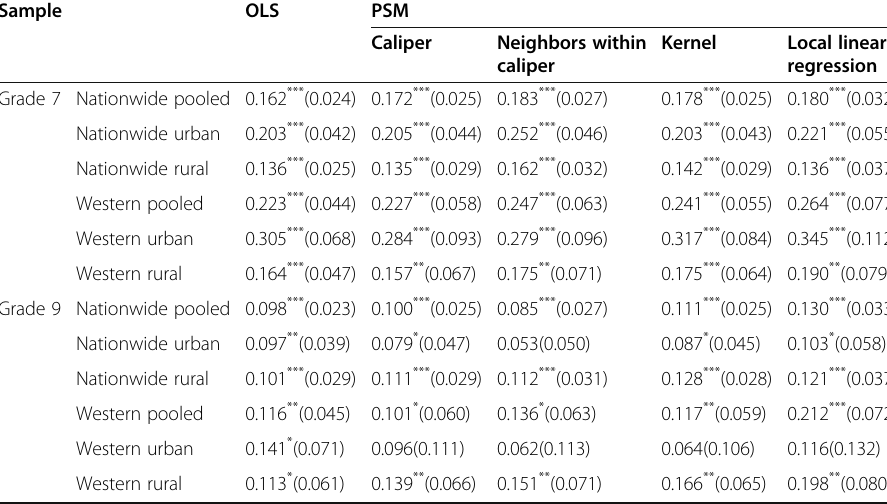
Table 3 The effect of preschool attendance on cognitive ability Sample OLS PSM